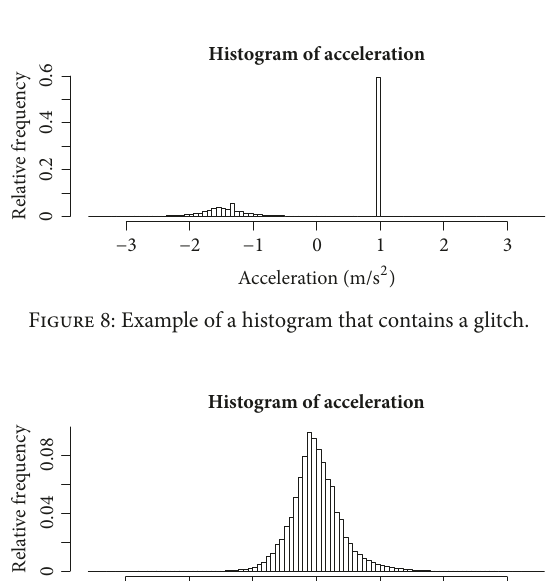
Figure 7: Histogram extraction from the acceleration data.